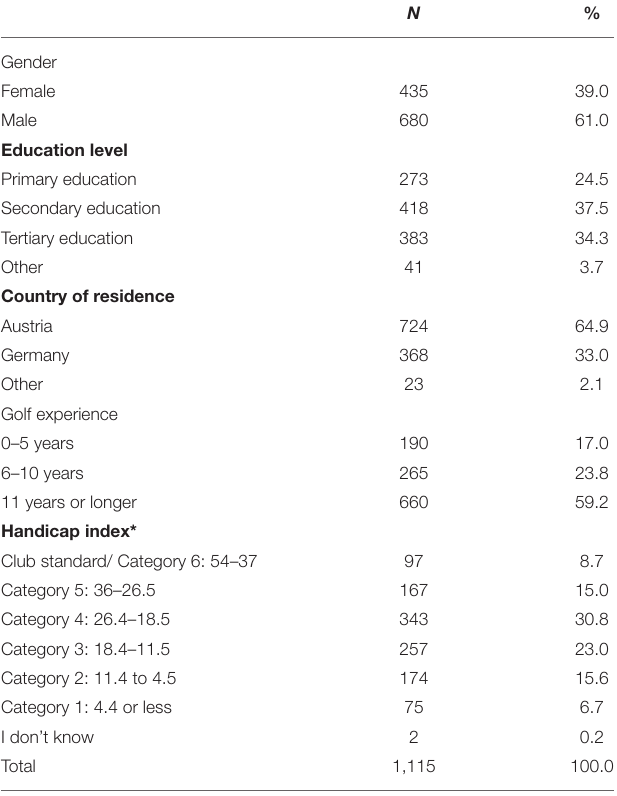
TABLE 1 | Sociodemographic characteristics of the study population ( n =